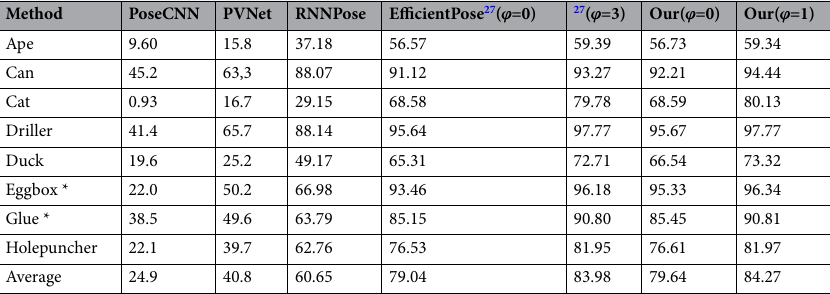
Table 3. ADD(-S) metric of multi object 6D pose estimation using a single model on the Occlusion dataset. Symmetric objects are marked with